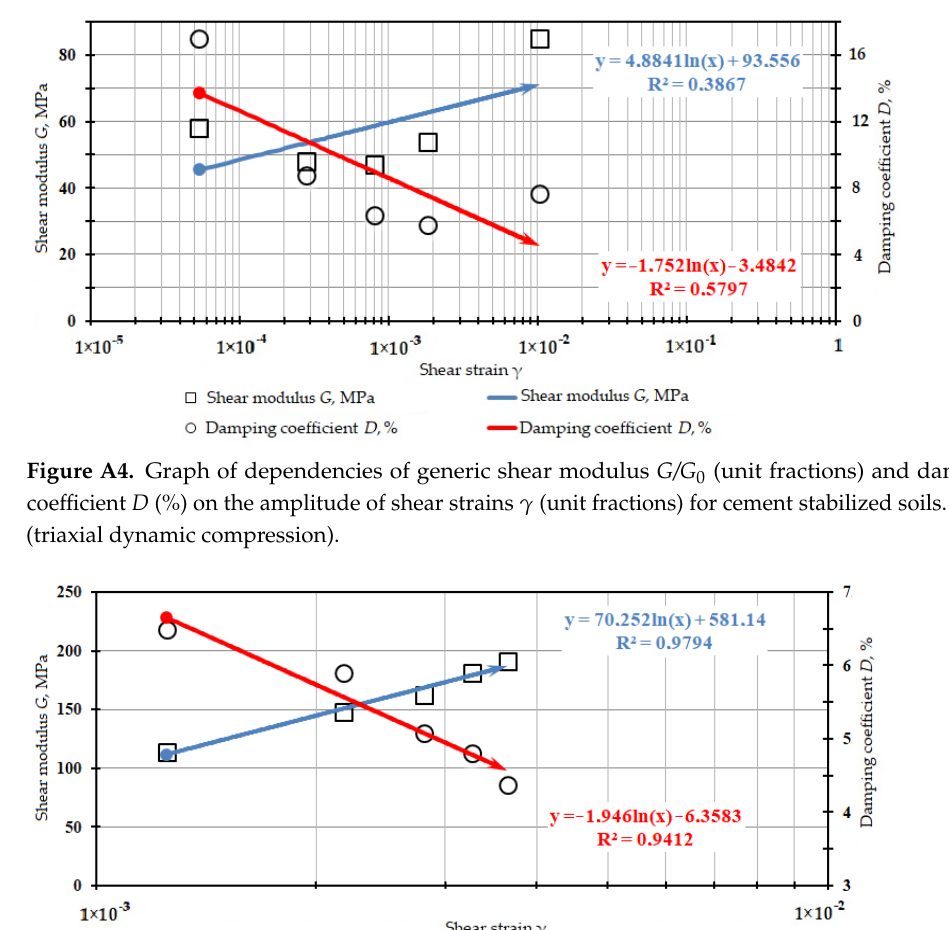
3 (resonant column).